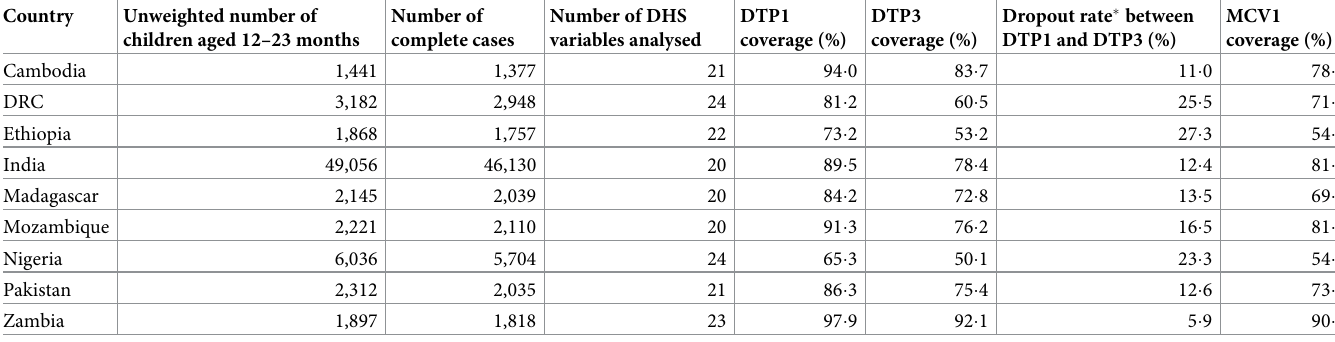
Table 1. Summary of DHS data and direct (or survey-weighted) estimates of DTP1, 3 and MCV1 coverage for all nine study countries.